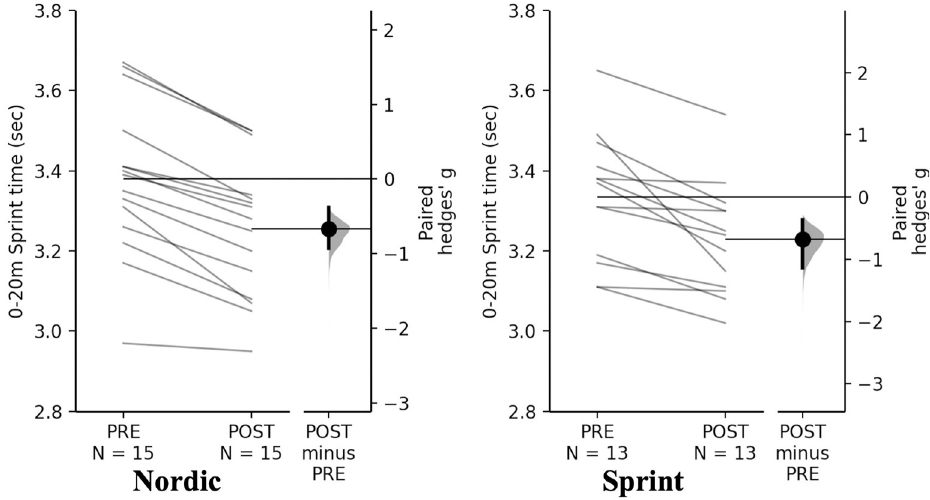
Fig 11. Gardner-Altman estimation plots identifying Pre- and Post-intervention individual changes for 0-20m sprint time and Hedge’s g effect size with the 95% CI indicated by the ends of the vertical error